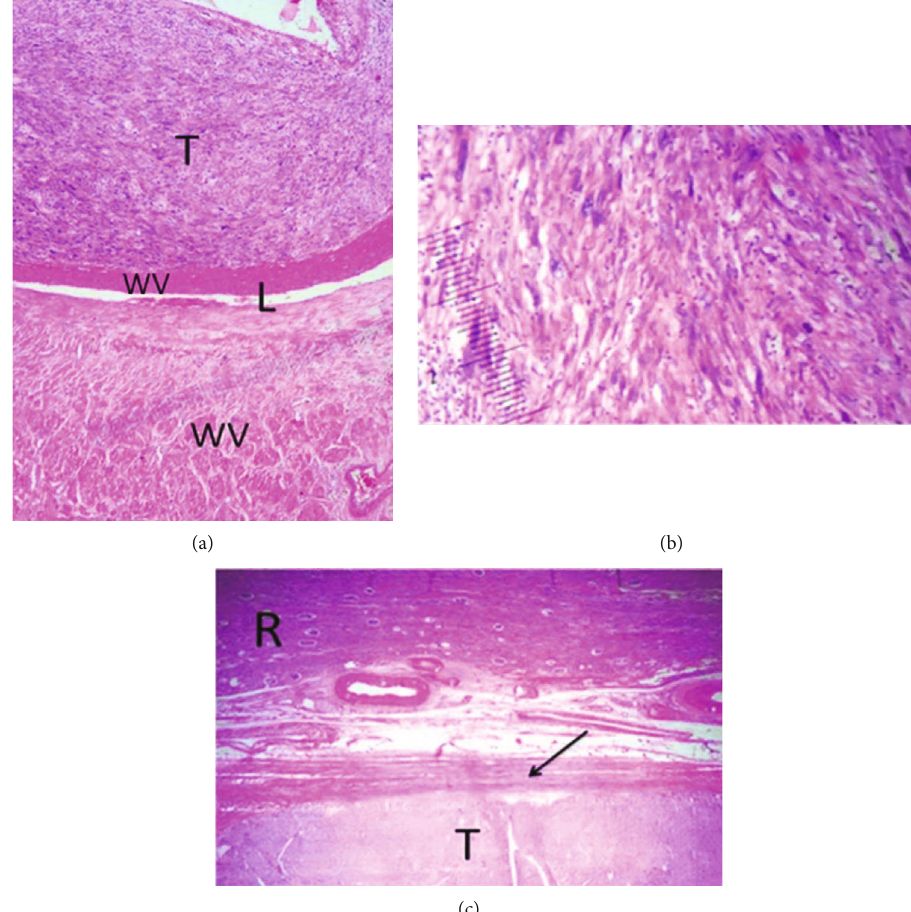
Figure 3: Hematoxylin and eosin staining. (a) A spindle cell neoplasm arranged in alternating fascicles arising from the wall of the renal vein. (b) The cells are spindle shaped with elongated blunt-ended nuclei, coarse chromatin, and eosinophilic cytoplasm. Presence of pleomorphic cells showing marked nuclear pleomorphism, hyperchromasia, and prominent nucleoli. (c) The tumor is encapsulated (arrow) compressing the residual renal parenchyma. T: tumor; L: vascular lumen; WV: wall of the renal vein; R: renal tissue; arrow: tumor